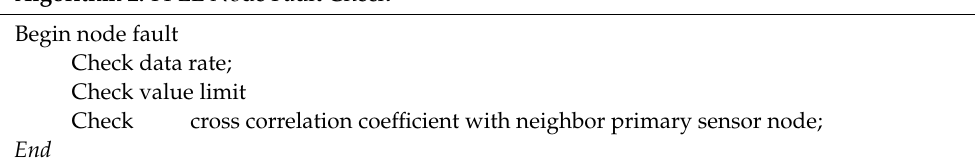
Algorithm 2: FPLE Node Fault